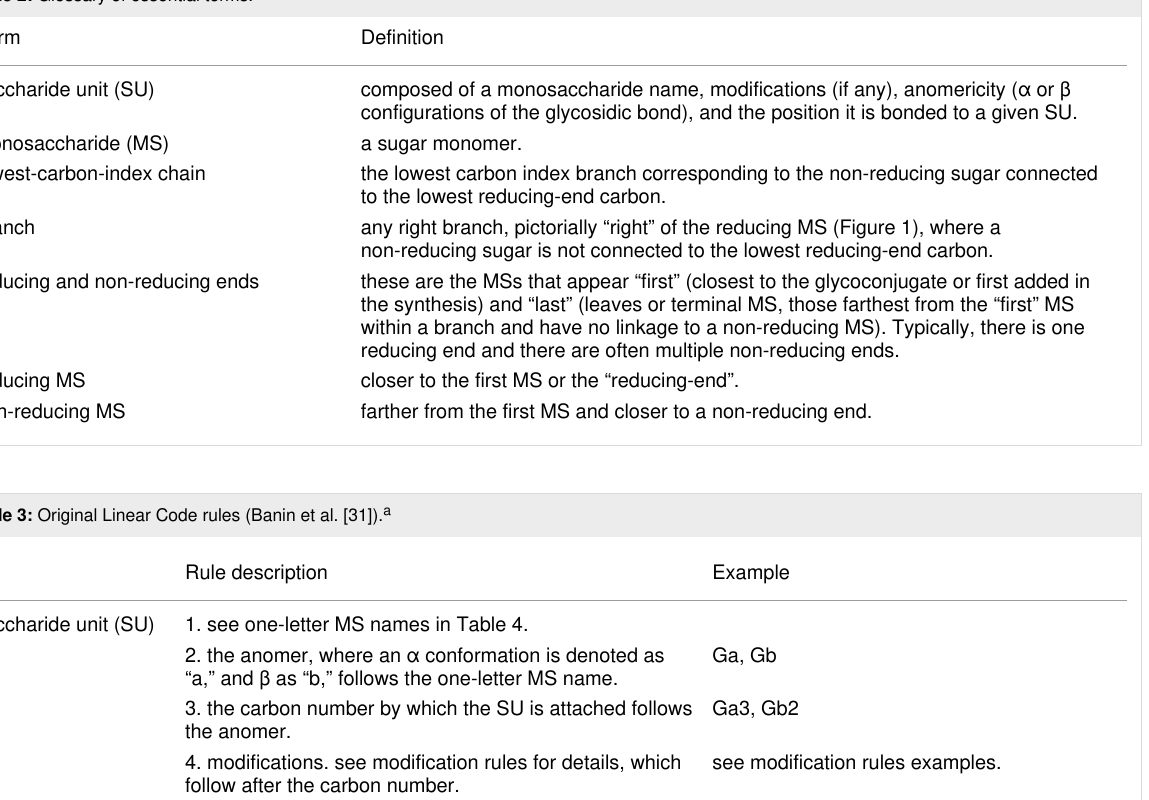
Table 2: Glossary of essential terms.